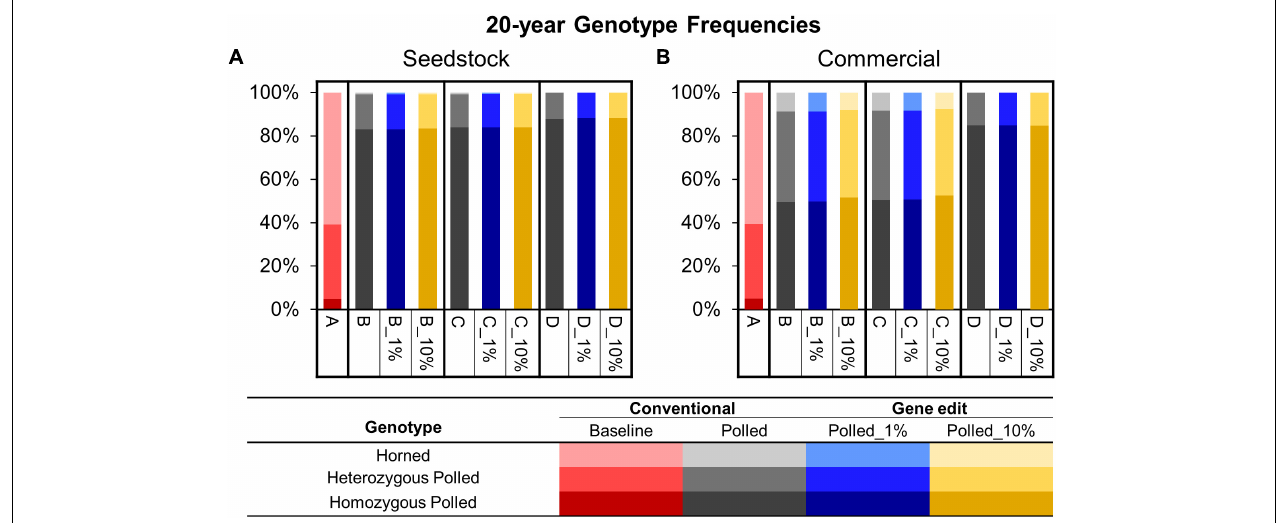
FIGURE 6 | Estimated genotype frequencies in year 20 of each scenario for the seedstock (A) and commercial (B) populations. Genotypes are represented by a color scale from darkest (homozygous polled) to lightest